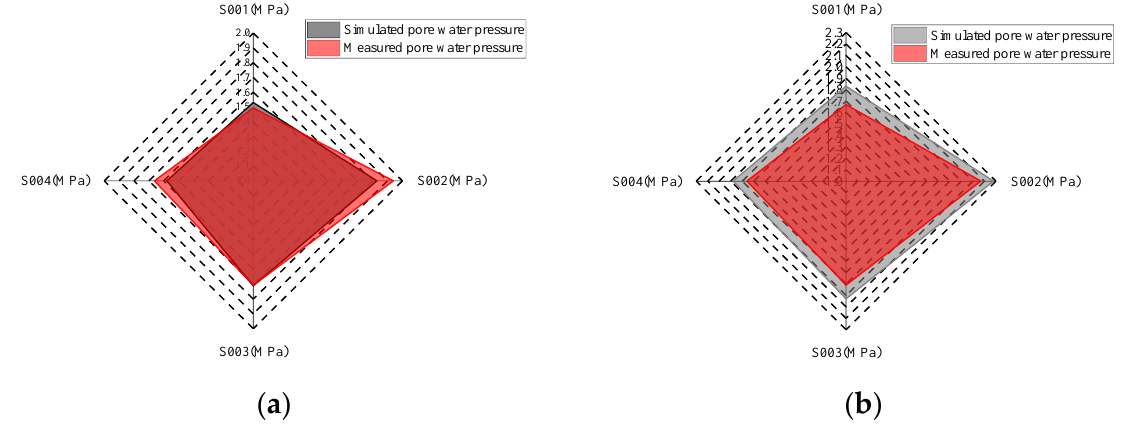
Figure 15. Comparison of simulation results with monitoring results. ( a ) S1ZK0 + 660 m; ( b ) S1ZK0 + 735 m.